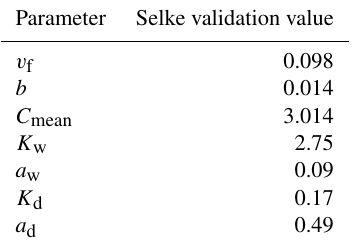
Table C1. Estimated parameter values for the Selke